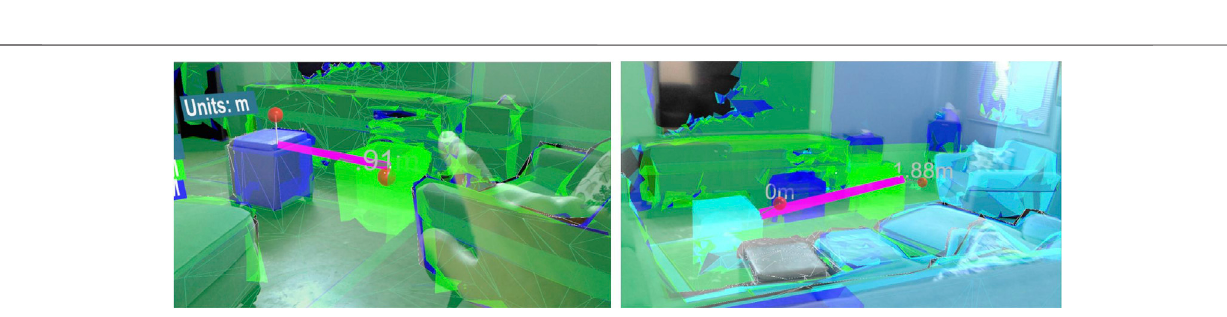
Frontiers in Built Environment |